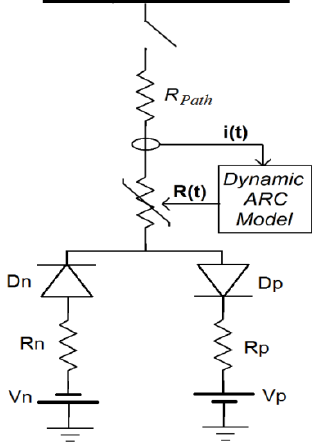
Figure 4.The combined model of HIF.